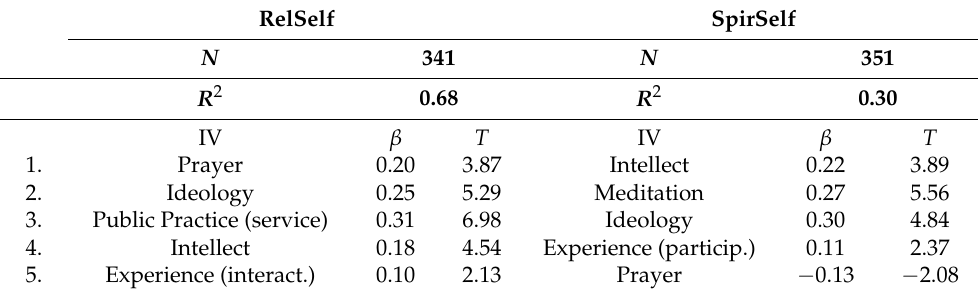
Table 9. Stepwise Regression Analyses to Explain the Religious and Spiritual